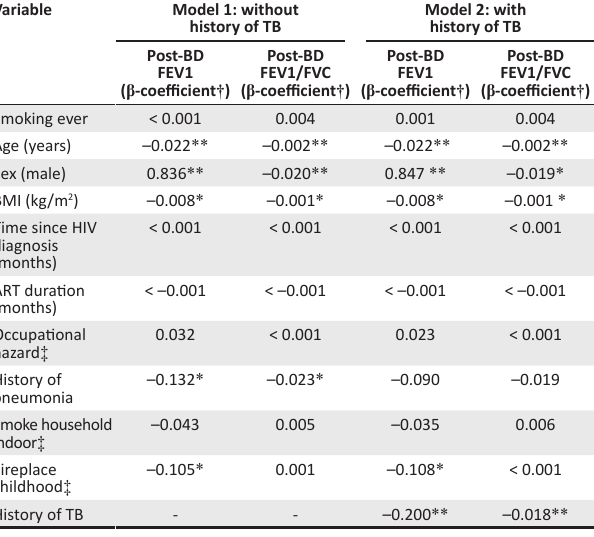
TABLE 1-A1: Results of multivariable analysis for post-bronchodilator (BD) forced expiratory volume in 1 second and the forced expiratory volume in 1 second/ forced vital capacity ratio, of imputed data sets. Model 1: without history of TB